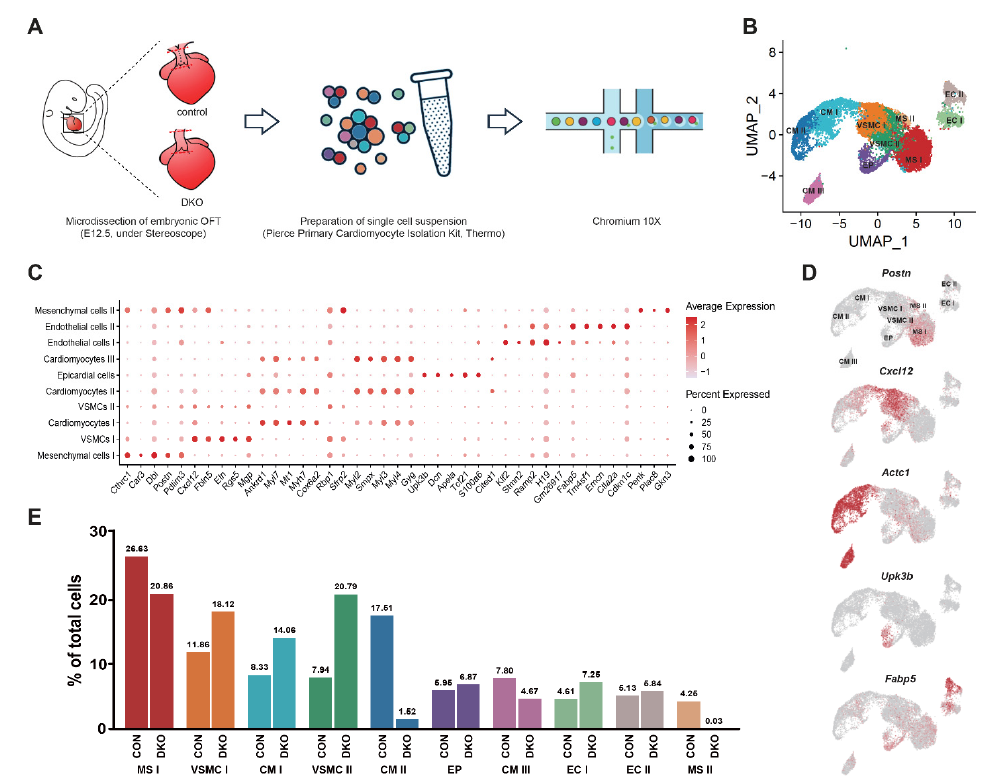
Figure 3. Single-cell transcriptome sequencing revealed a profile of cell cluster, lineage, and propor- tion. ( A ) Overview of the experimental procedure. Embryonic OFT was micro-dissected (red dotted line) under a stereoscope and built library by Chromium 10× for single-cell transcriptome sequencing. ( B ) Unsupervised clustering of aggregate OFT cells revealed 10 cell clusters projected on UMAP plots. ( C ) Dot plot showing expression of top up-regulated genes across OFT cell clusters. ( D ) Ex- pression of select marker genes across OFT cells as visualized on UMAP plots (MSs: Postn ; VSMCs: Cxcl12 ; CMs: Actc1 ; epicardial cells: Upk3b ; and endothelial cells: Fabp5 ). ( E ) Cell population per- centages of each cluster between DKO and control group. MS, mesenchymal cell; CM, cardiomyo- cyte; VSMC, vascular smooth muscle cell; EP, epicardial cell; EC: endothelial cell; CON, control; DKO, double knockout; UMAP, uniform manifold approximation and projection; OFT, outflow tract.